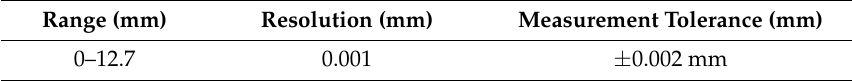
Figure 1. Flexible rolling apparatus ( a ) forming equipment ( b ) the schematic ( c ) forming process ( d ) the measuring instrument for thickness. Table 1. The metrological characteristic of digital